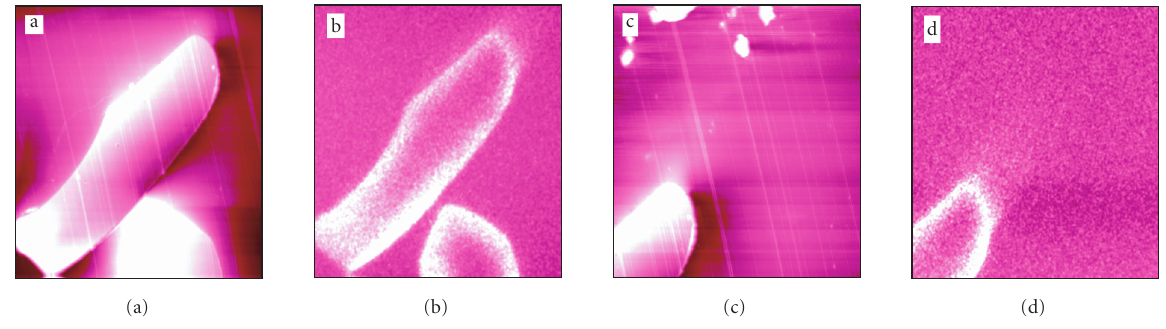
Figure 44: Simultaneous shear-force AFM (a) (50 μ m, Z range 1 μ m), (c) (50 μ m, Z range 560nm), and fluorescence SNOM (b), (d) of microtome cut surfaces of a partly dyed polyester fiber (dye 14 ) embedded in Agar 100, showing the ring dyeing in the optical